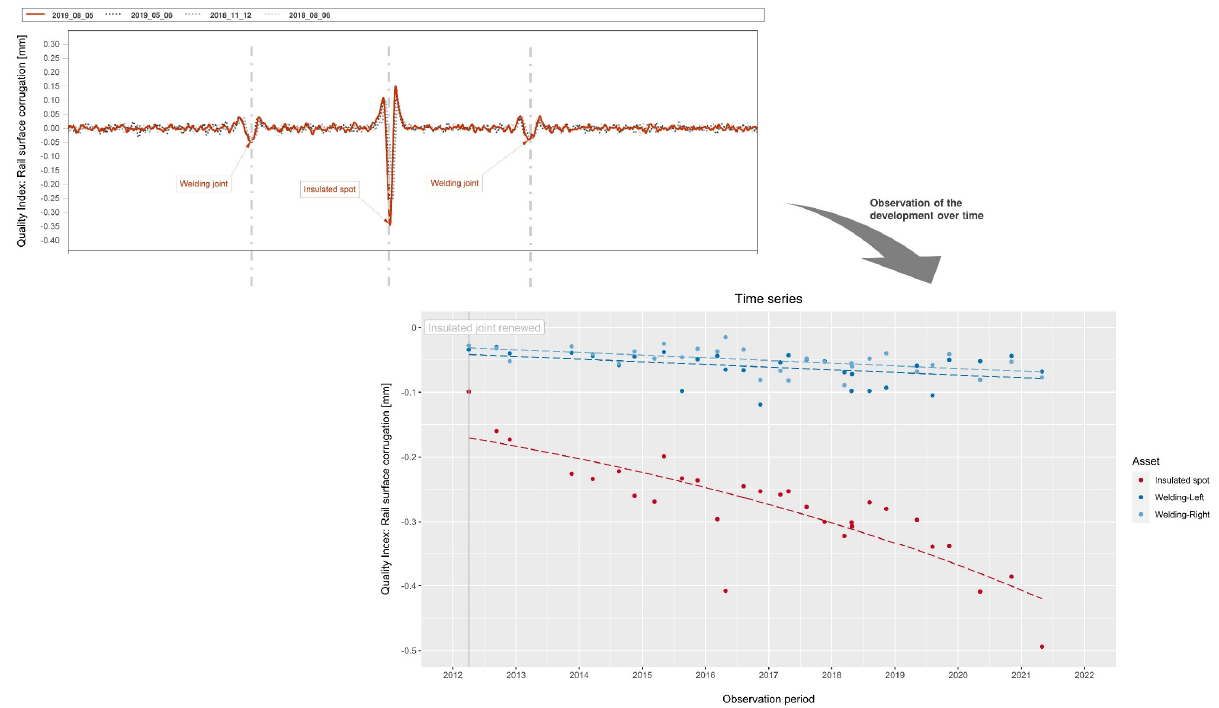
Figure 4. The time development of the rail surface signal in response to an insulated rail joint .